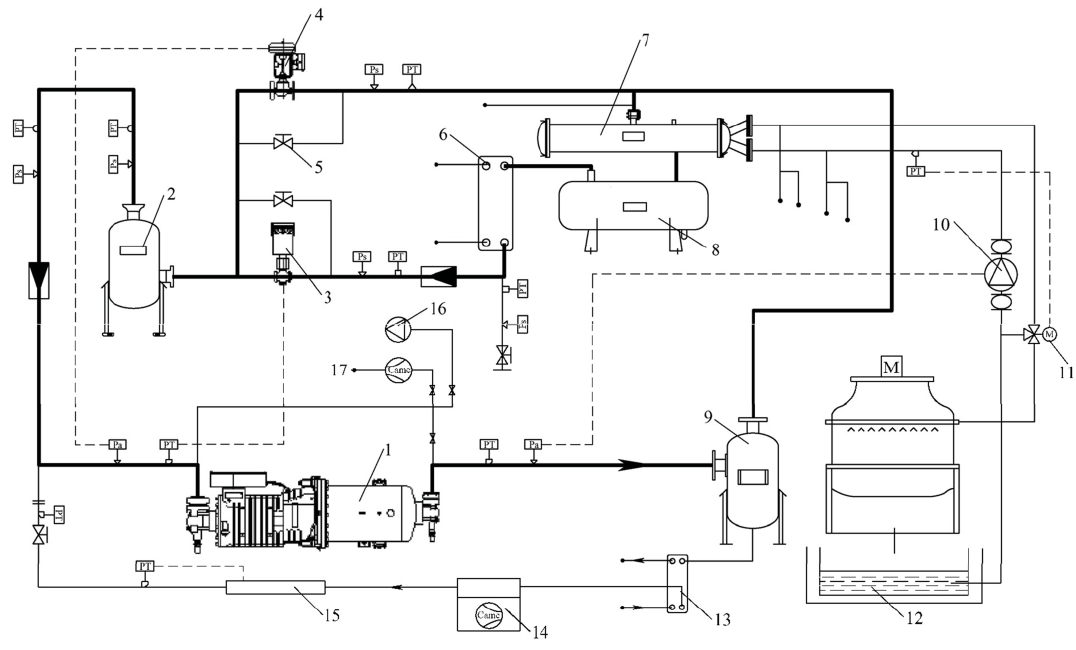
Figure 11. The schematic diagram of refrigerant compressor test system.